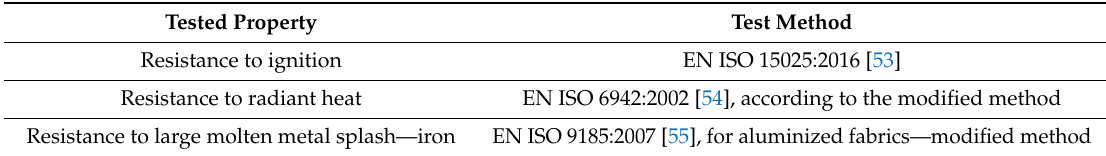
Table 3. Test methods.